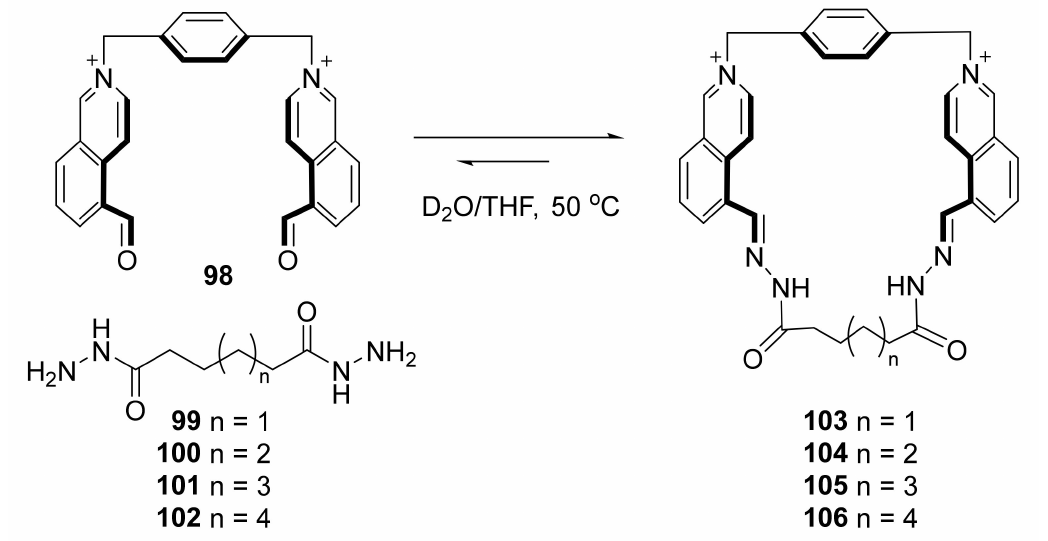
Figure 19. Synthesis of water-stable cationic bishydrazides 103 – 106